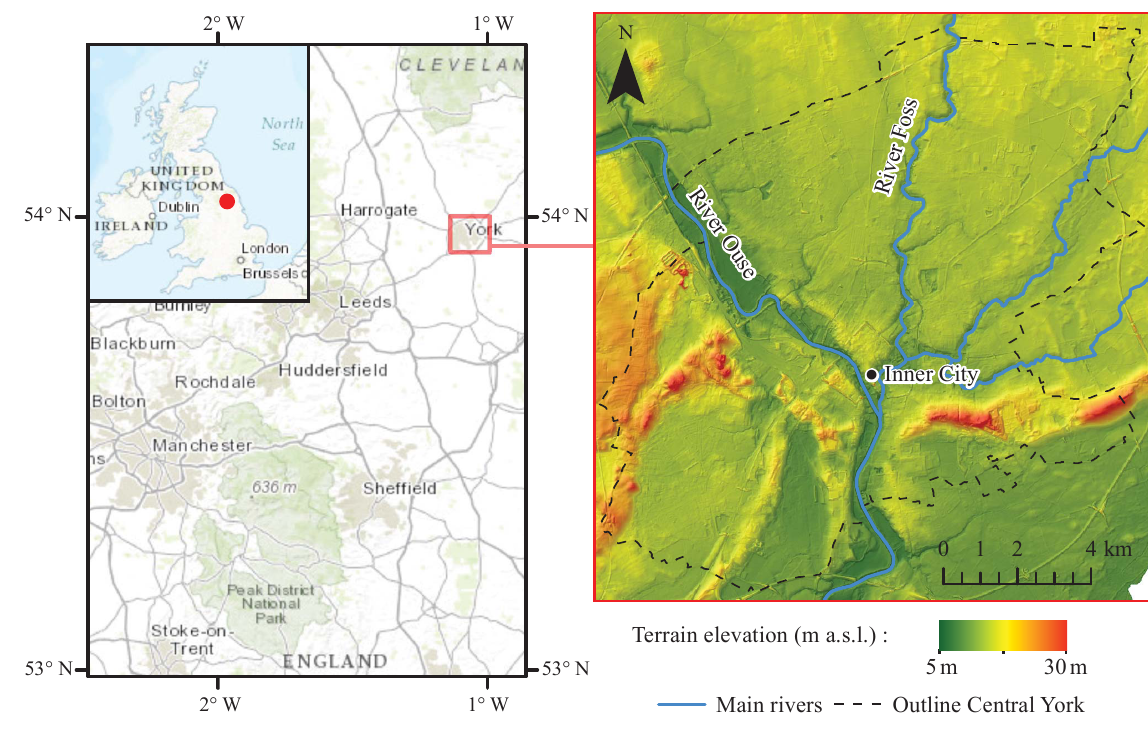
Figure 1. Digital terrain model of the York study